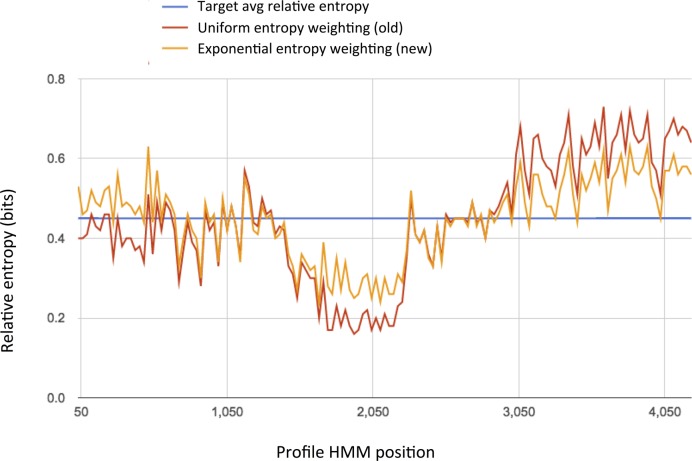
Impact of exponential entropy weighting on position-specific relative entropy. L1PREC2_5end (DF0000315) per-position relative entropy averaged over 30 bp windows with uniform and exponential entropy weighting functions. The region around position 1900 caused both false hits and overextension of true hits when using uniform entropy weighting; most of these were removed with the higher positional relative entropy generated using exponential entropy weighting.